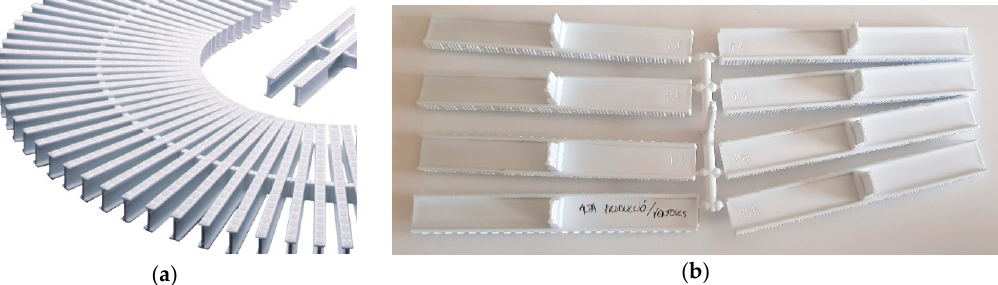
Figure 1. PP plastic ribs that are the object of the case study. ( a ) Assembly of a chain of ribs into a swimming pool water sink cage. The assembly can form a straight line or follow curves (picture courtesy of Fluidra group). ( b ) A set of 8 ribs resulting from an injection operation.